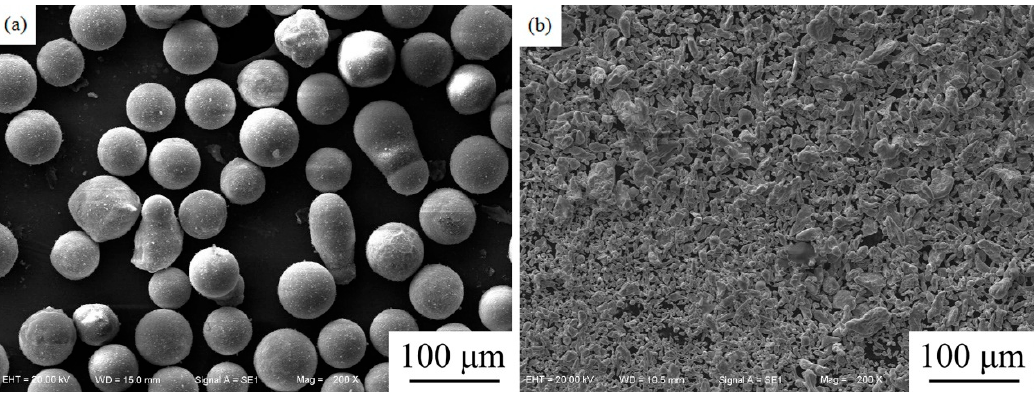
Figure 1. Morphologies of powders. ( a ) ZK61, ( b ) Zn. Table 1. The abbreviations of different Mg-Zn-Zr alloys.